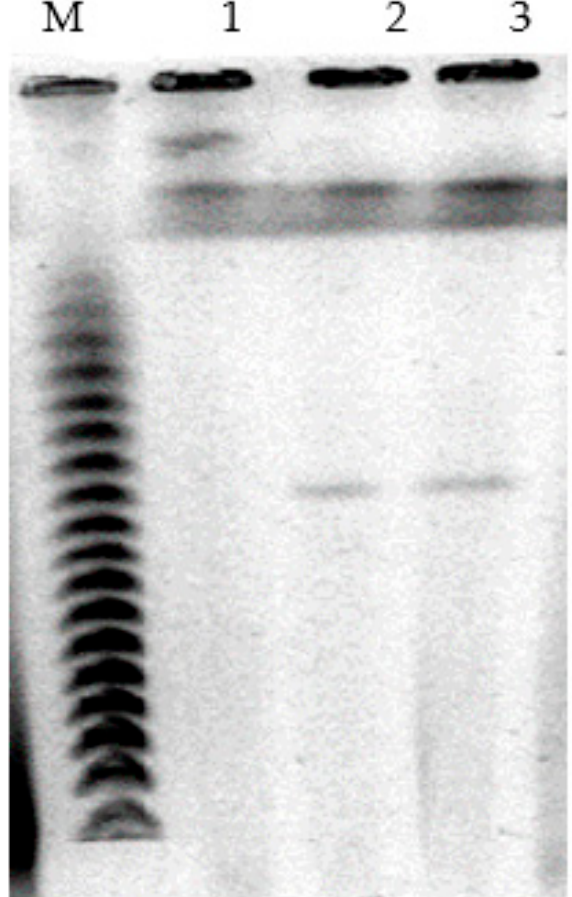
Figure 2. Electropherogram of plasmid DNA of P. putida strain Ch2 and P. putida KT2442(CAP): M—Lambda Ladder PFG Marker (New England BioLabs), 1—a plasmid-free recipient strain of P. putida KT2442, 2—wild-type P. putida strain Ch2, 3—a transconjugate strain of P. putida